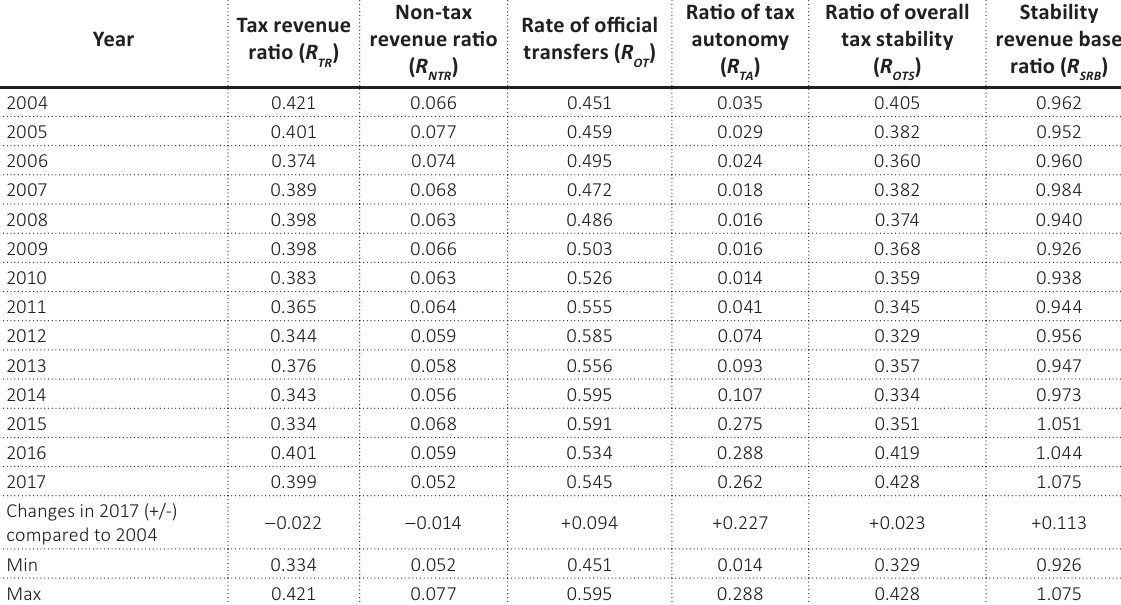
Table 3. Fiscal policy decentralization indicators by structure of local budgets Source: Authors’ calculations based on data from CASE Ukraine (2019).